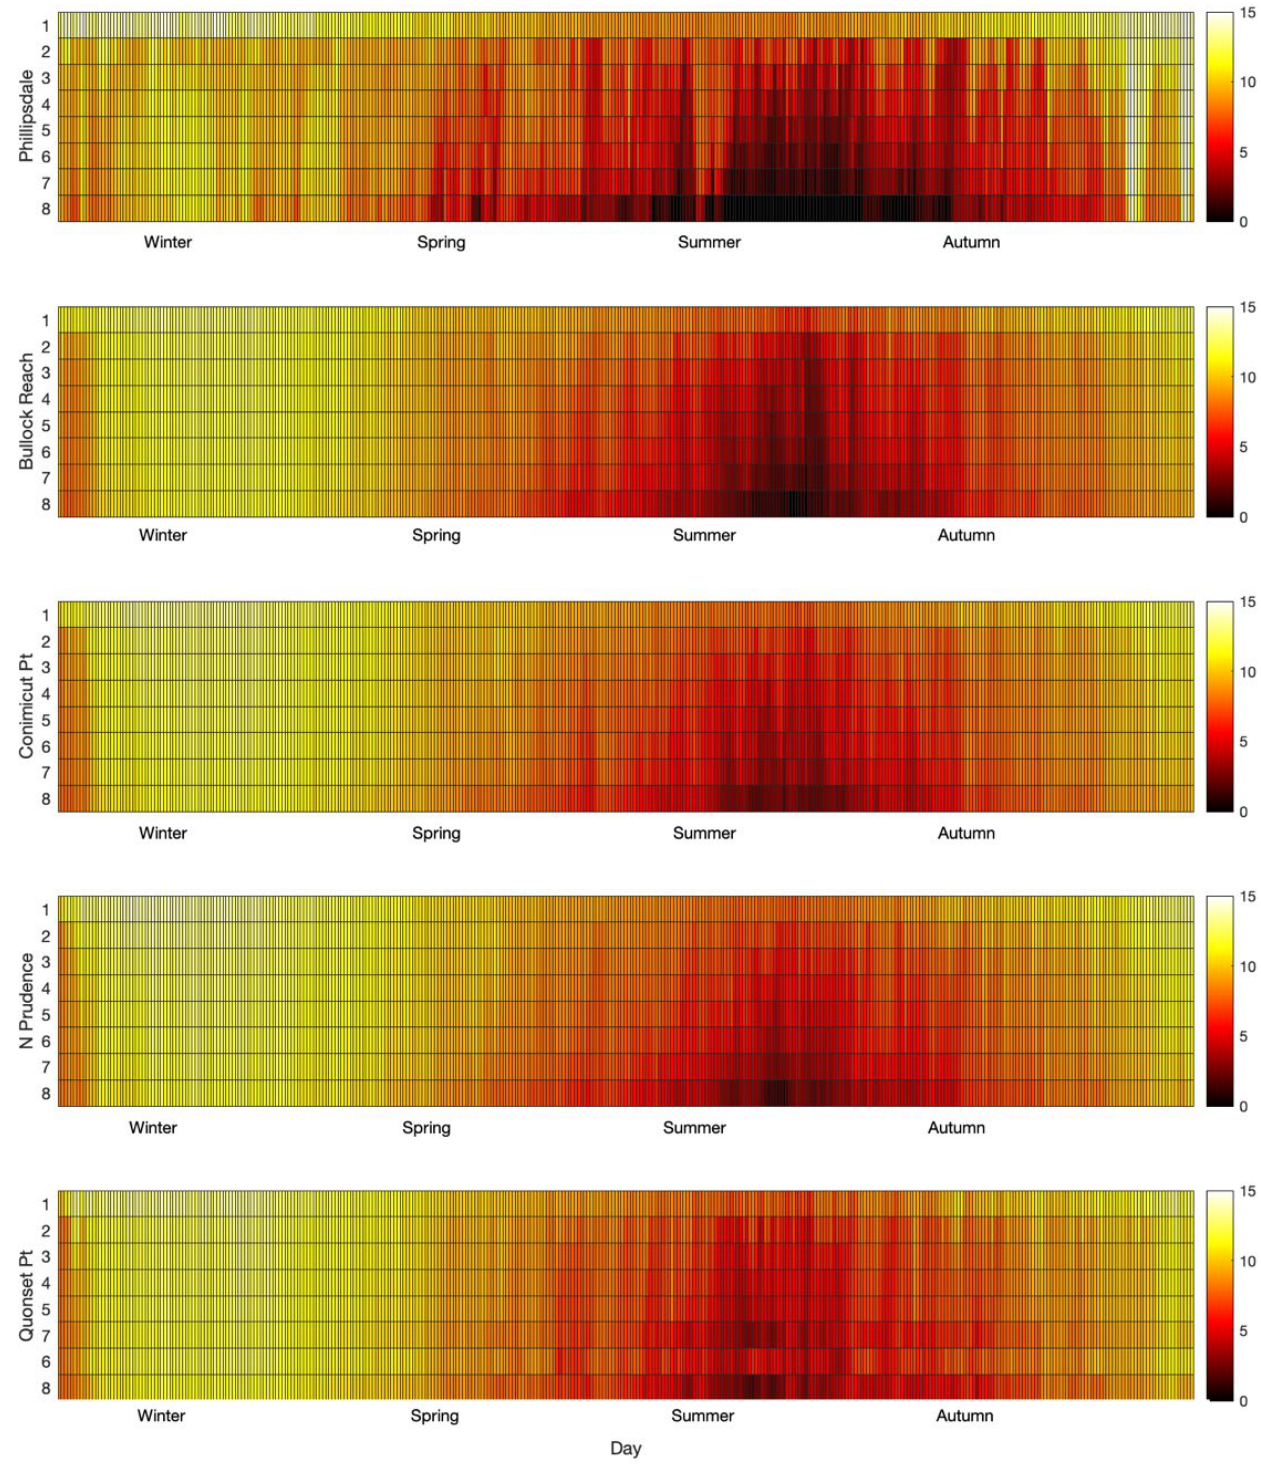
Figure 8. Simulated dissolved oxygen concentrations with time (day) on the x-axis and depth as layer on the y-axis for five locations from north to south. Each square represents the DO for a given day in that layer on that day at the location. DO ranges from 0 mg L − 1 (black) to 15 mg L − 1 (white). For the mid-depth and deep layer DO, there is much more variability due to the different model scenarios. For all of scenarios, the removal of sediment influence increases DO in the mid-depth and deep waters for all locations. For Phillipsdale, there is a